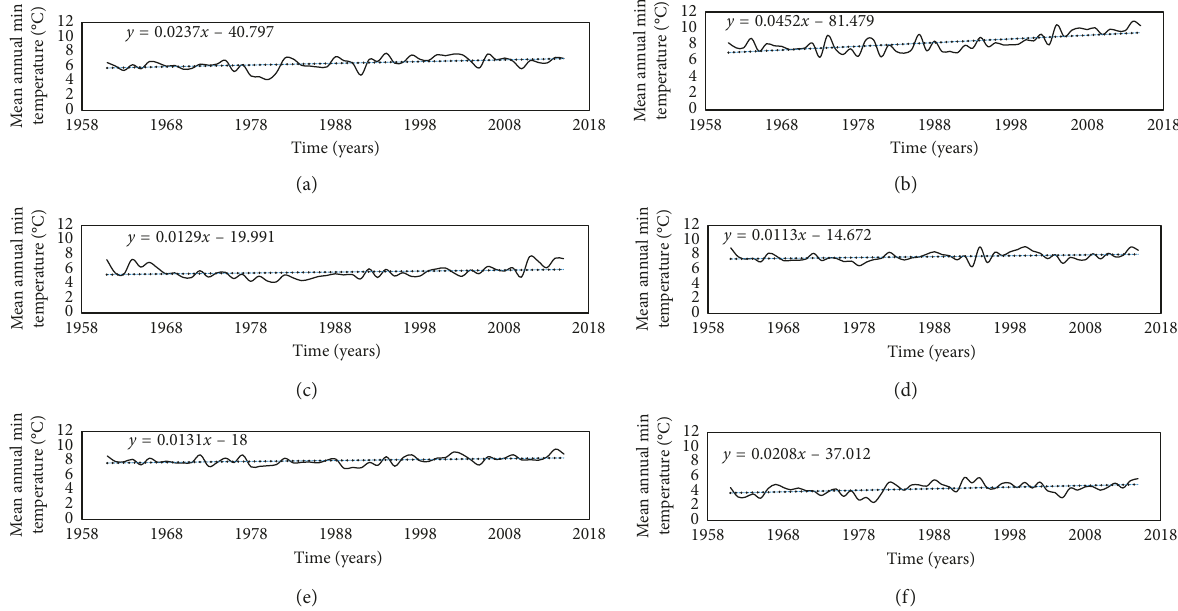
Figure 8: Temporal variation and trend line of annual minimum TTfor six meteorological stations during the period 1961–2015. (a) Verghereto, (b) Reggio Emilia, (c) Bedonia, (d) Vigoleno, (e) Conselice, and (f) Abetone. For the locations of the weather stations, refer to Figure